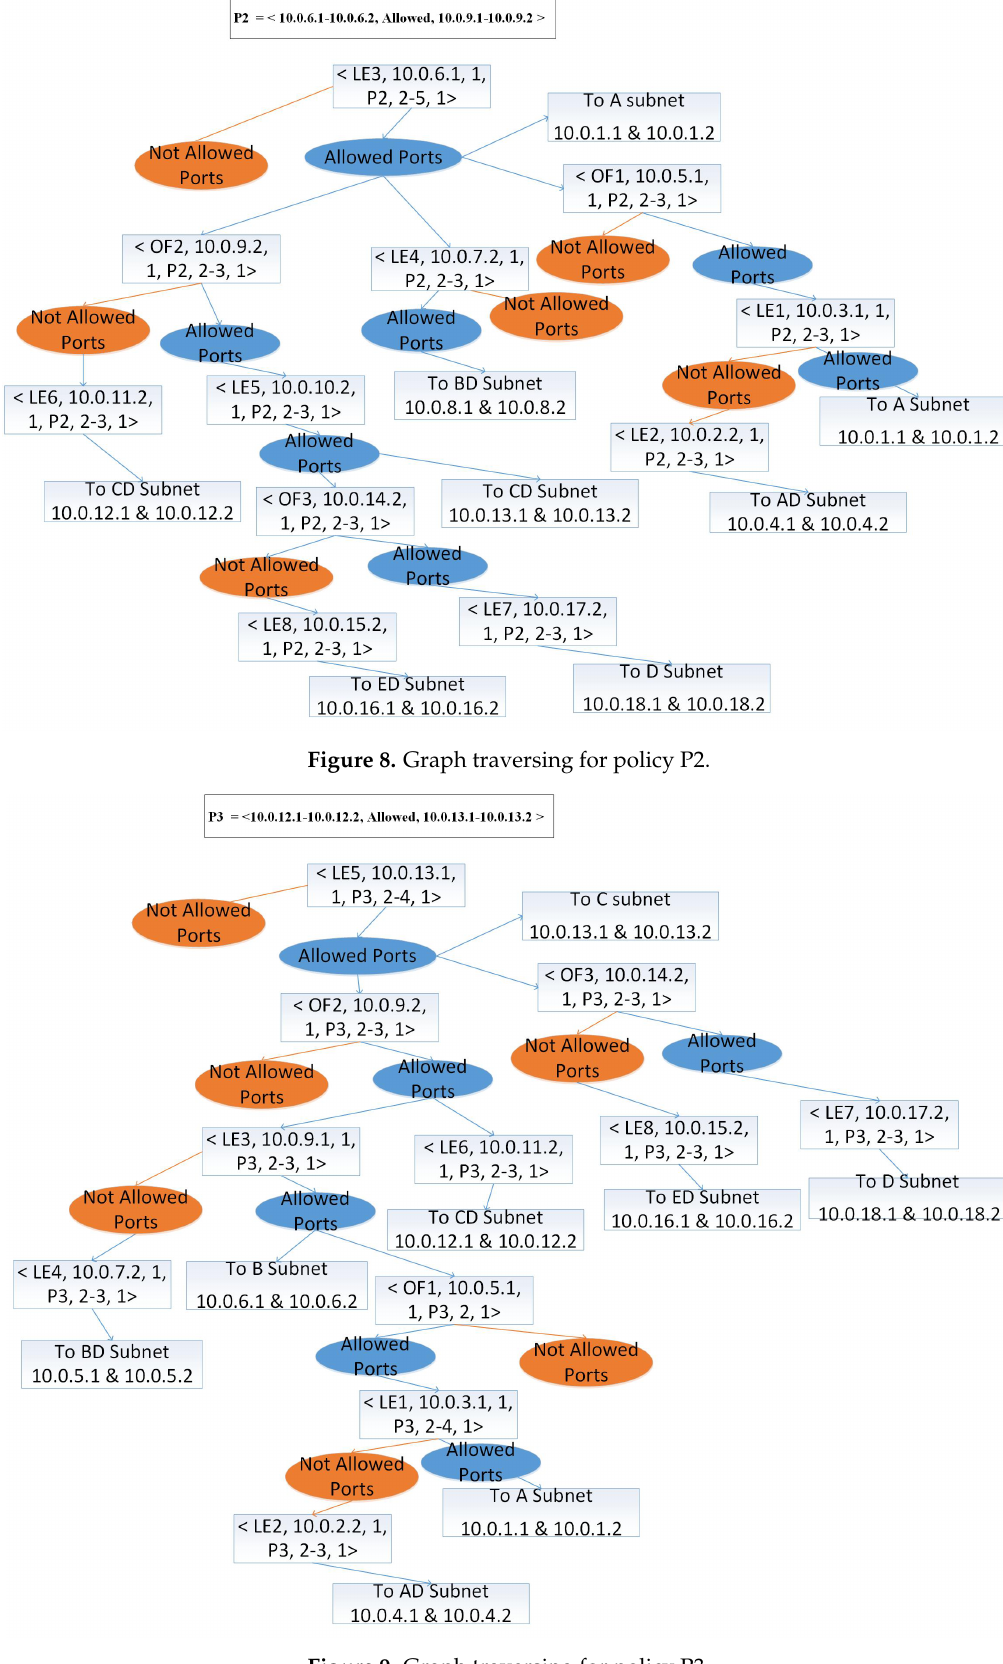
Figure 9. Graph traversing for policy